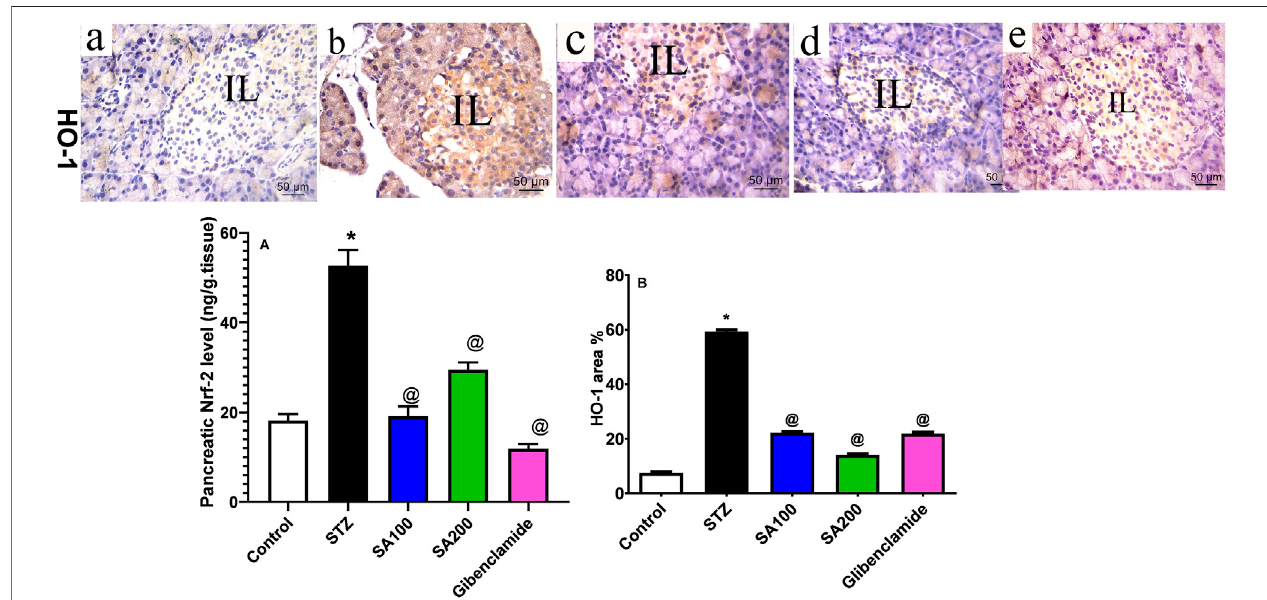
FIGURE 6 | (Upper panel) Immunostained photomicrographs pancreatic sections presenting nuclear erythroid factor 2 (Nrf-2) and heme oxygenase-1 (HO-1). Normal rats (A) , STZ diabetic rats (B) , S. aqueum (SA) extract (100 mg/kg) (C) , S. aqueum (SA) extract (200 mg/kg) (D) , and the reference drug, glibenclamide (E) .